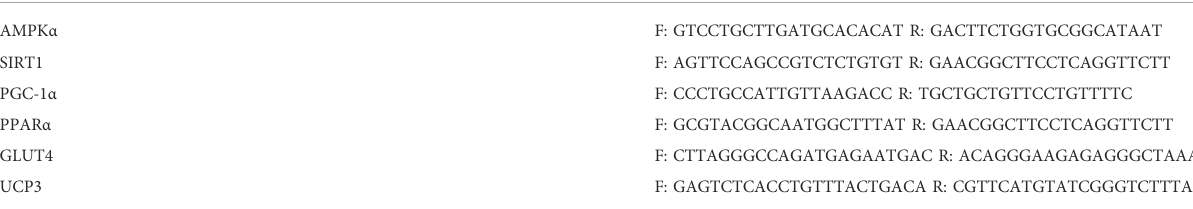
TABLE 1 Sequences of the objective gene